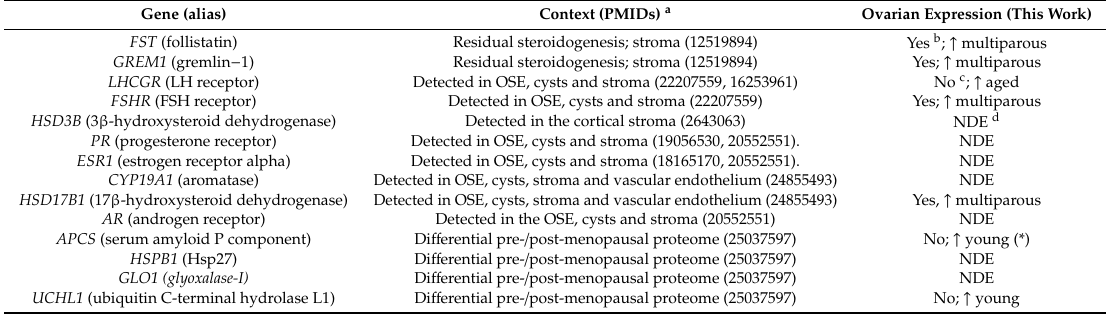
Table 1. Previous knowledge on gene expression in the human post-menopausal ovary. Gene (alias) Context (PMIDs) a Ovarian Expression (This